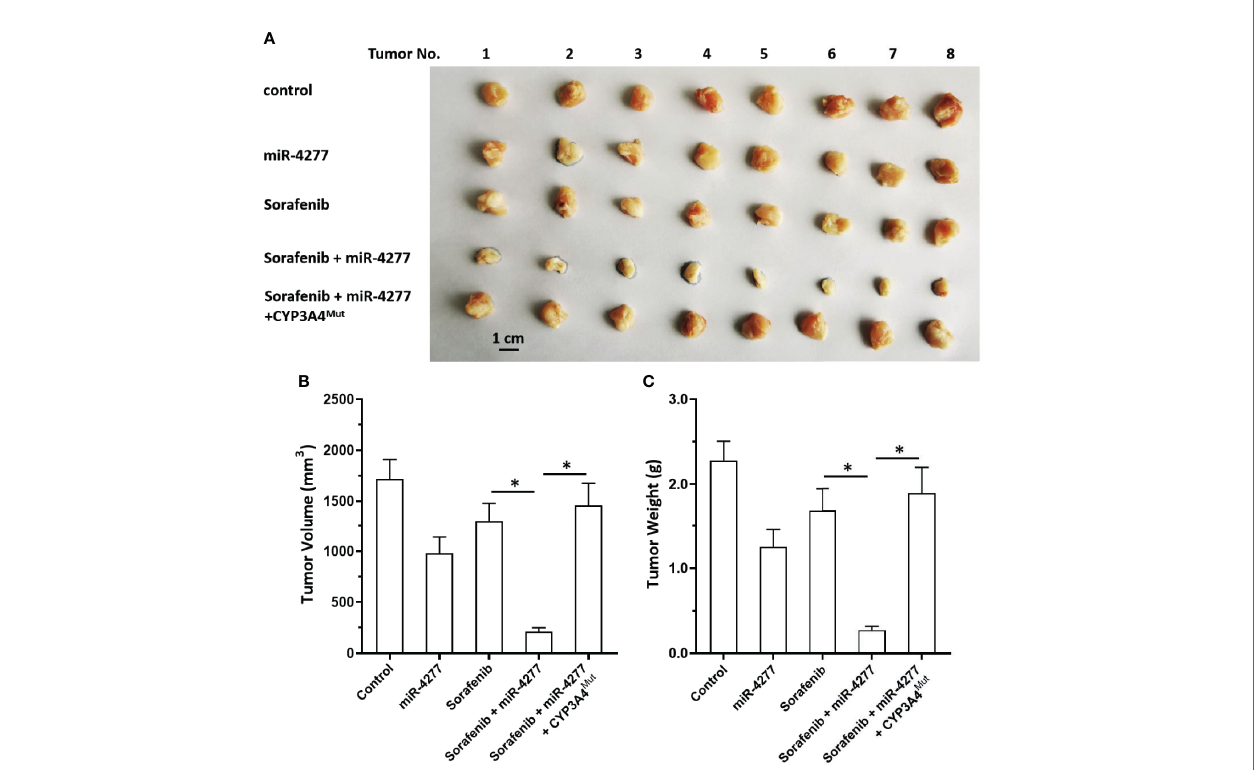
FIGURE 6 | miR-4277 enhances the antitumor effect of sorafenib in a nude mouse model. MHCC97-H cells were transfected with vectors (control miR, miR-4277, or miR-4277 + CYP3A4 Mut ) and subcutaneously injected into nude mice. The mice then received the indicated dose of sorafenib via oral administration. The results are shown as tumor images (A) , tumor volumes (B) , or tumor weights (C) . *P < 0.05.